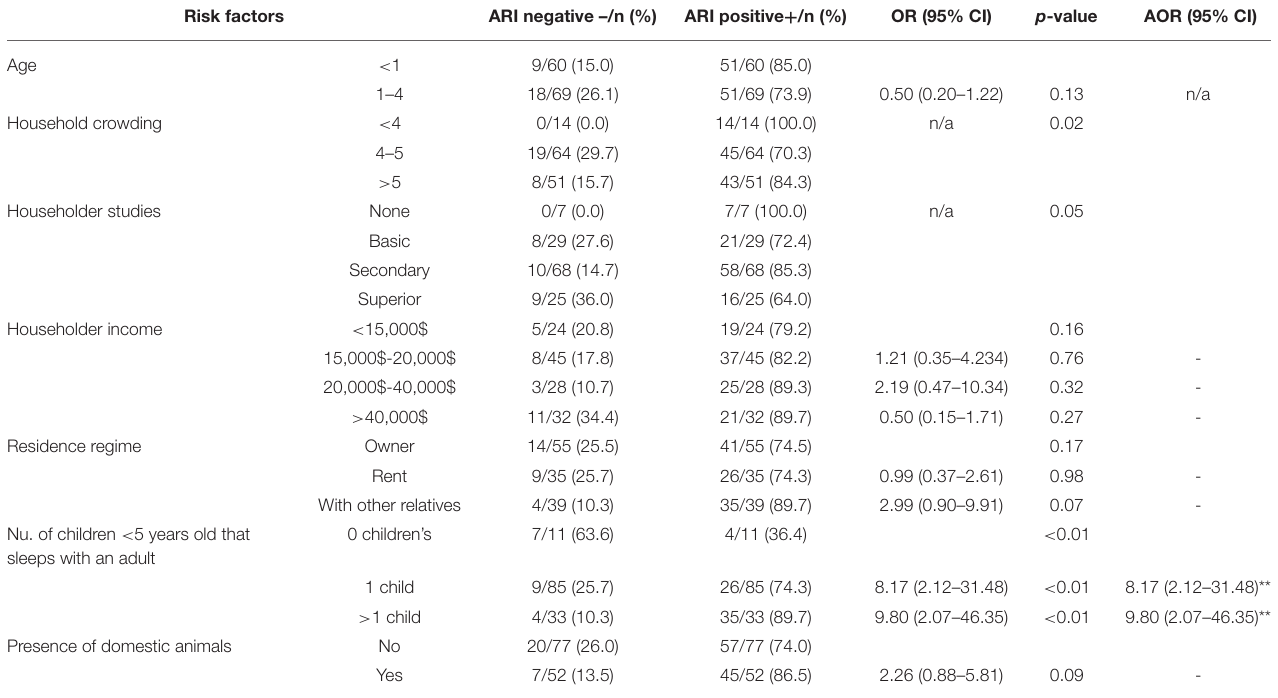
TABLE 4 | Risk factors for